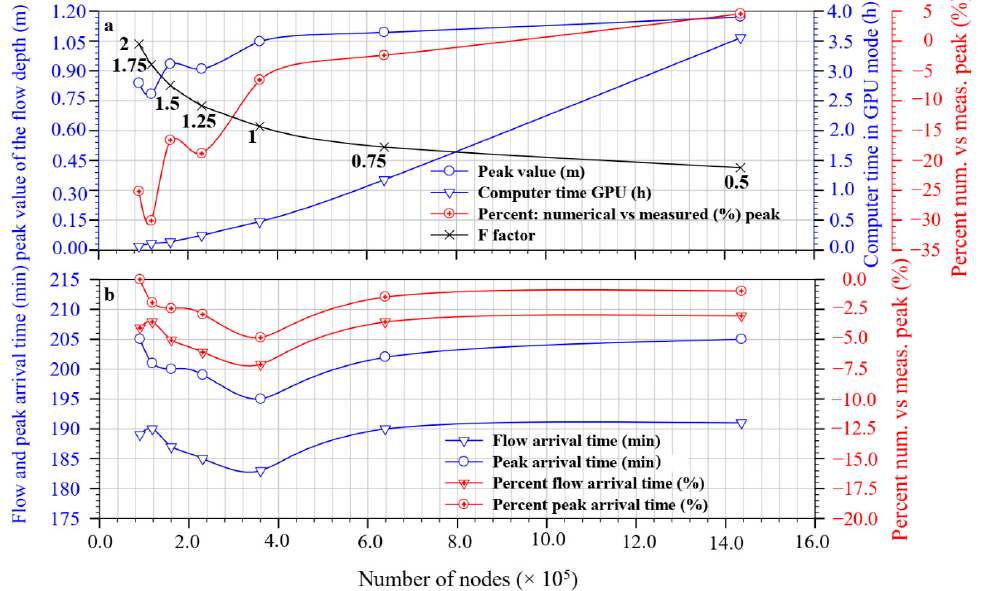
Figure 10. Simulations S19–S30, according to the number of nodes: ( a ) HighPeakVal , Computational time in GPU mode, Percentage of the deviation among the numerical values of the peak and the corresponding measured values, F Factor; ( b ) FlowArrTime , PeakArrTime , Percentage of the deviation among the numerical values of the flow and peak arrival times and the corresponding measured values.